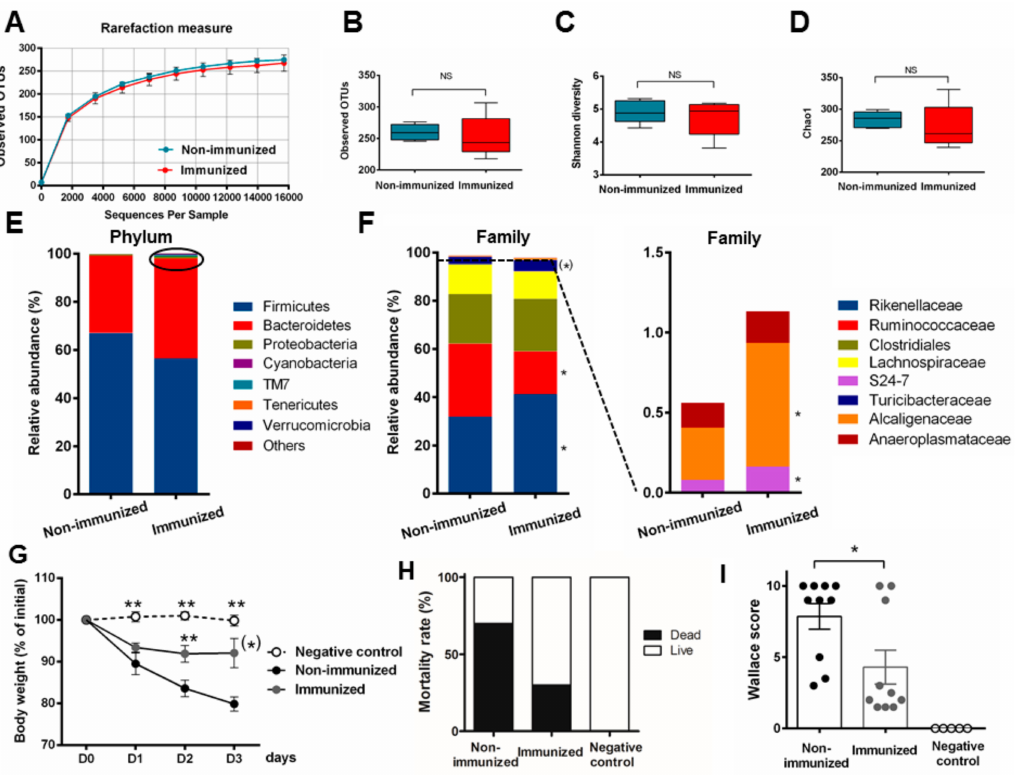
Figure 4. Immunization of BALB / c mice by P28GST + Adjuvant in another set of experiments reproduced subtle changes in fecal microbiota and consistently prevented inflammation in a more severe 2, 4, 6-trinitrobenzene sulfonic acid (TNBS)-induced colitis. ( A ) Rarefaction curves of observed operational taxonomic units (OTUs) as a function of reads show a similar number of sequences in the fecal samples of control (non-immunized) and immunized group of mice. Boxes and whiskers represent ± min / max of observed OTUs ( B ) Shannon index ( C ) and Chao 1 ( D ), respectively, showed no greater di ff erences in alpha diversity and richness. Mean relative abundance at the phylum ( E ) and family level ( F ) with a focus on the low-represented OTUs at the family level (below 2%) for each group of mice. Results are expressed in % of the total OTU number, n = 5 per group for microbiota analysis ( A – F ). ( G ) Percentage of loss of initial weight (prior colitis, at day 36 = D0) expressed as the comparison of individual weights recorded at killing (day 39 = D3) as means ± SEM. ( H ) Mortality rate recorded at day 39, expressed in % of initial mouse number and ( I ) macroscopic clinical (Wallace) scores of colons at day 39 in both the non-immunized and immunized group of mice; means ± SEM. n = 10 per group for colitis evaluation parameters ( G – I ); * p < 0.05; ** p < 0.01; ( * ) 0.05 < p <